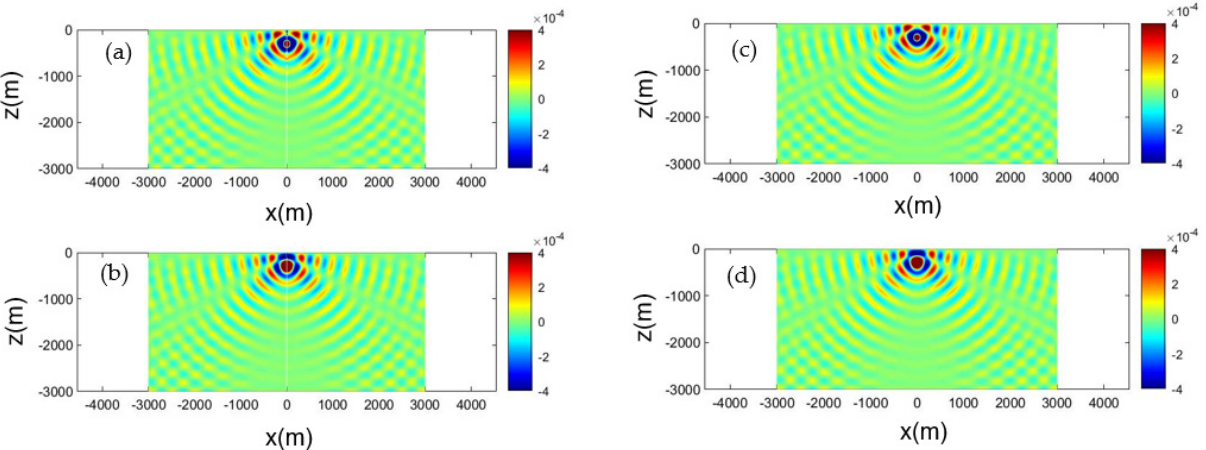
Figure 4. Calculated acoustic field corresponding to the monopole source, Equation (20). Source frequency 5 Hz, at submergence depth z 0 = − 300 m, in an isovelocity c = 1500 m/s ocean acoustic waveguide of depth h = 3000 m. Left column result obtained by the normal mode series, keeping 40 terms: ( a ) real part, ( b ) imaginary part. Right column: field obtained from the mirror series using six terms: ( c ) real part, ( d ) imaginary part.